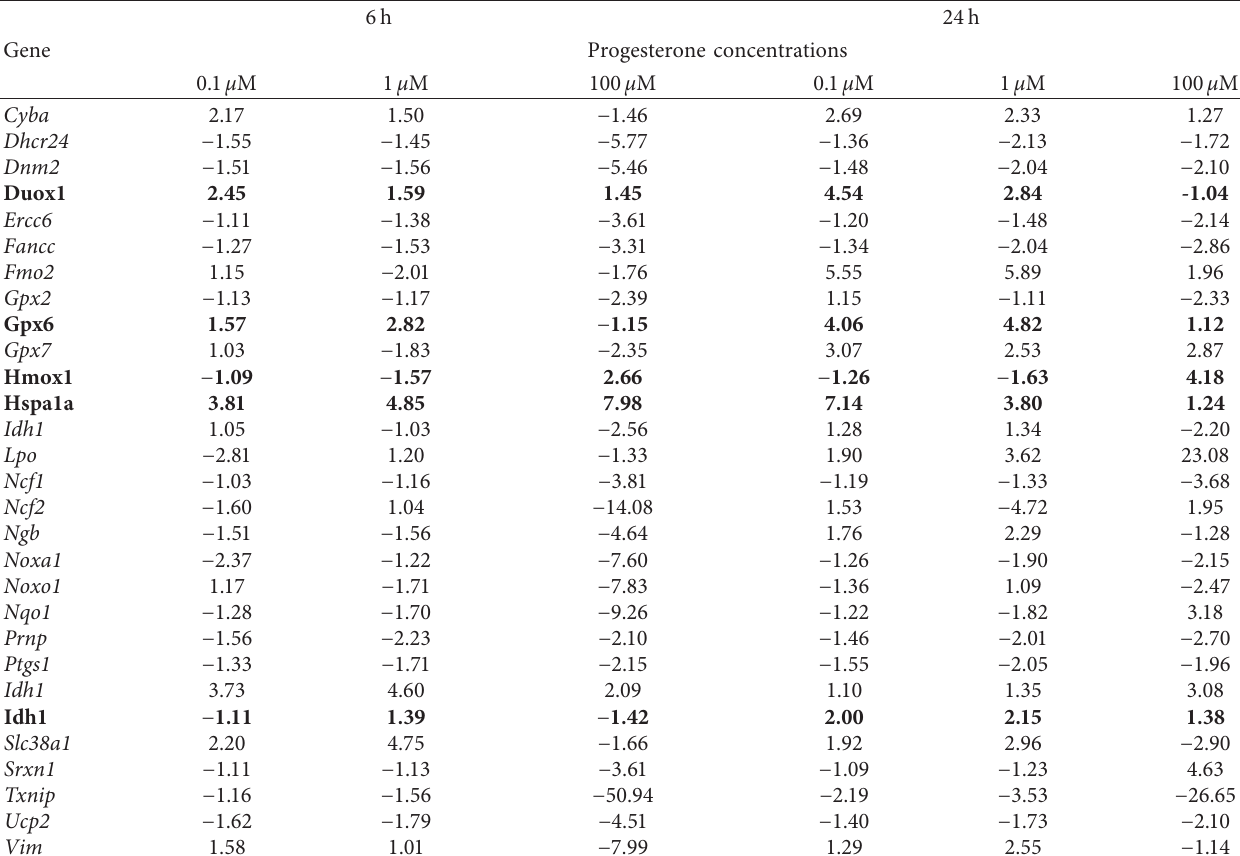
Table 1: Regulated genes in progesterone-treated RINm5F cells evaluated by PCR